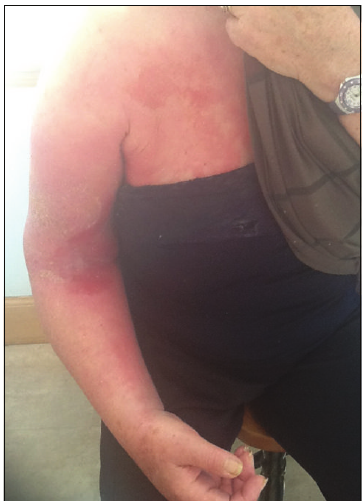
Figure 2: Erythematous blistering rash over the skin in contact with the brace material.